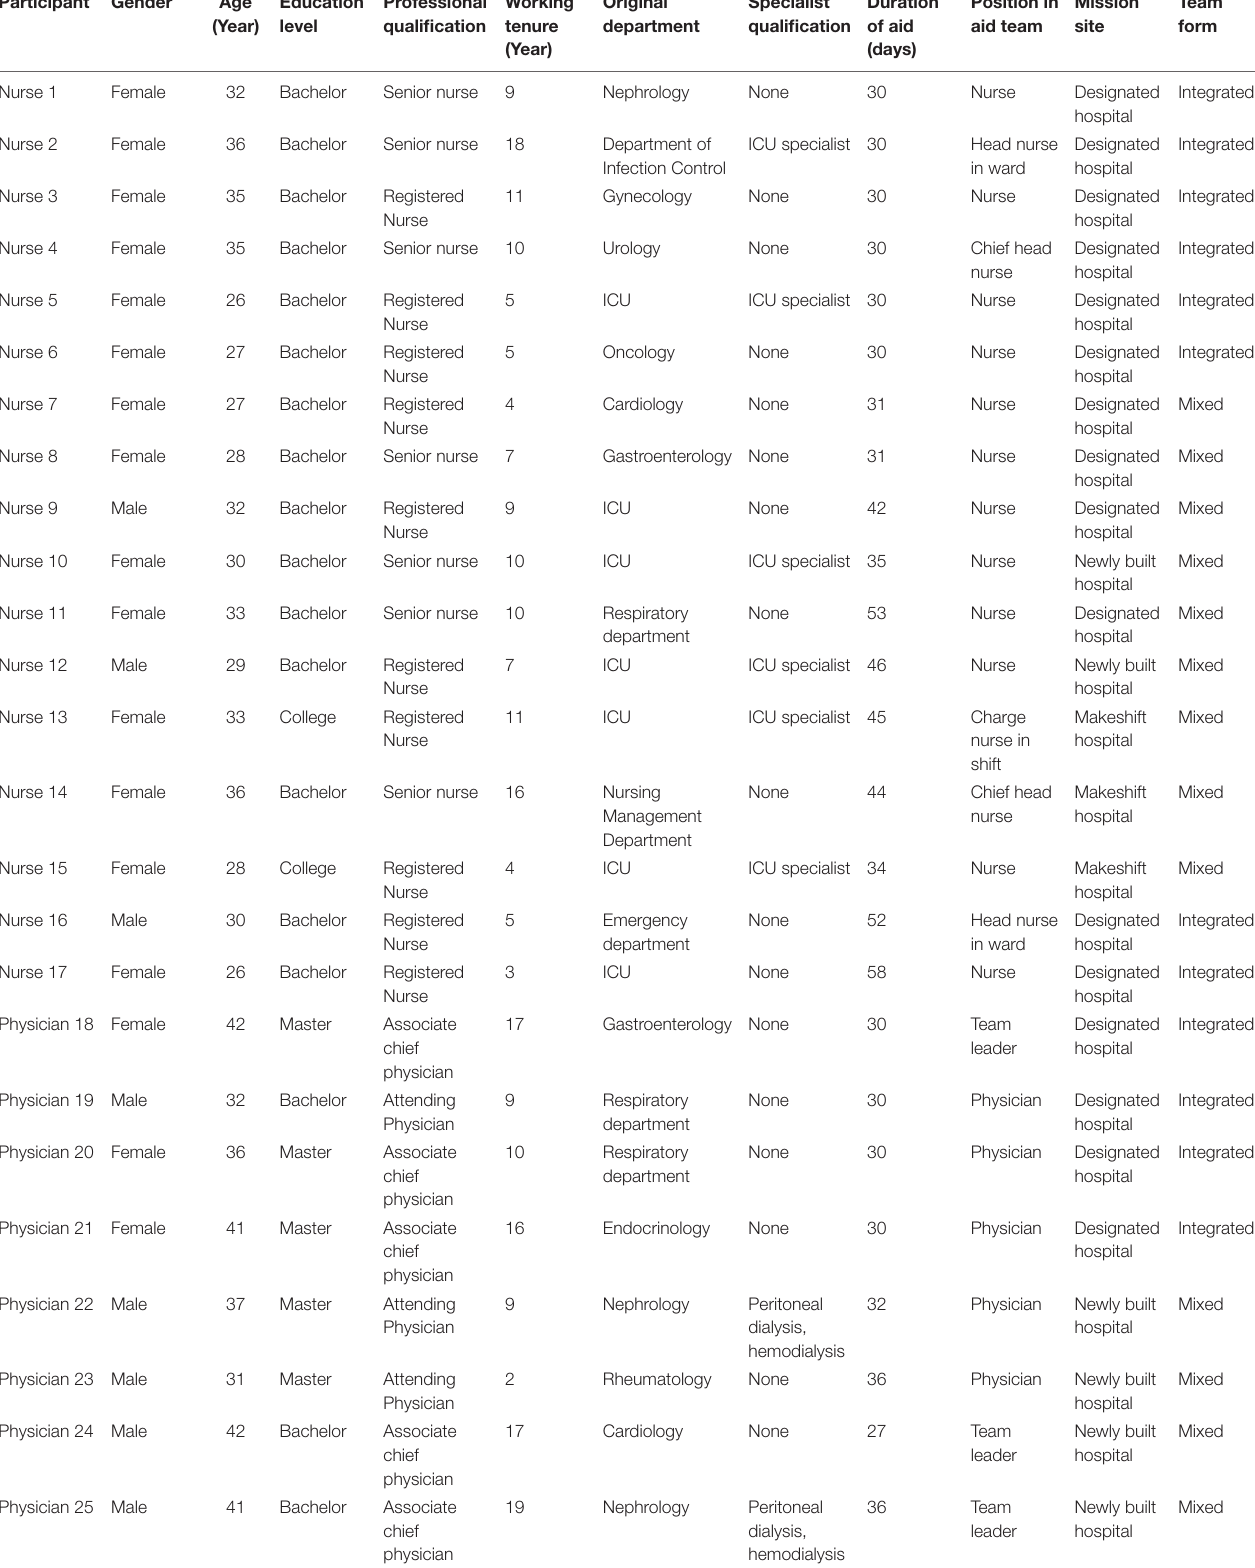
TABLE 1 | Demographic characteristic of the healthcare workers (HCWs) ( N =